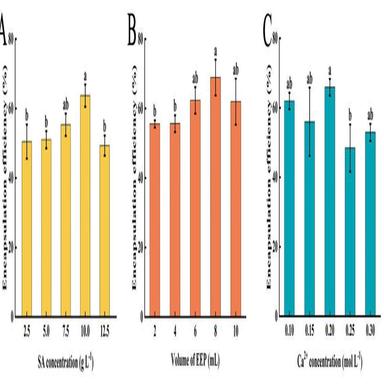
Effects of SA concentration (A), volume of EEP (B), and calcium ion concentration (C) on the EE of PM. different lowercase letters on the data indicate significant difference among different groups (p < 0.05).